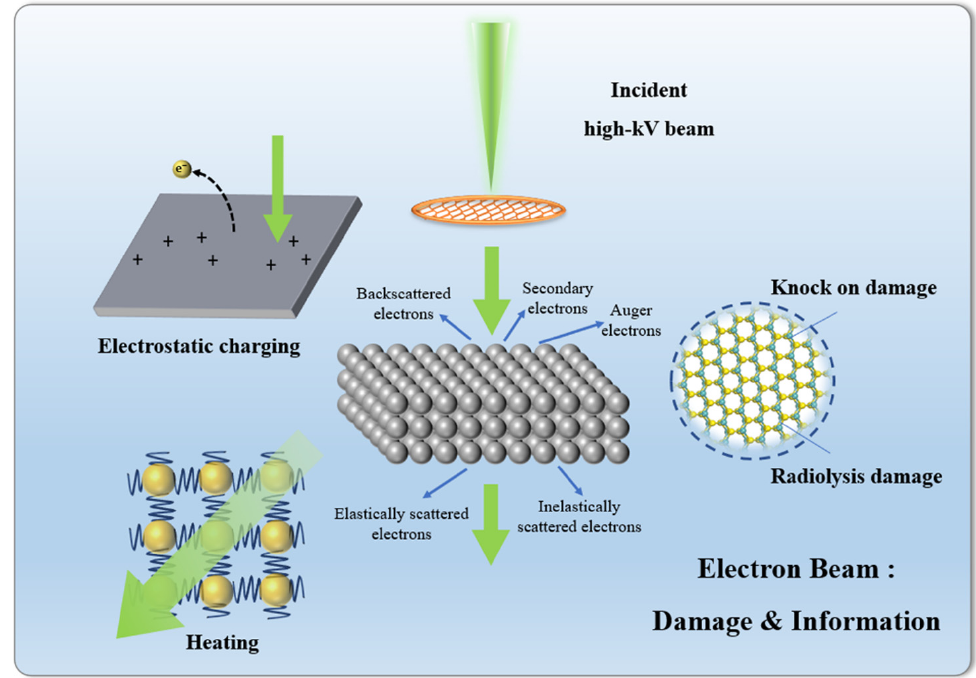
Figure 2. High-energy electron beams will inevitably introduce damage while reducing structural information: knock on damage, radiolysis damage, electrostatic charging, and